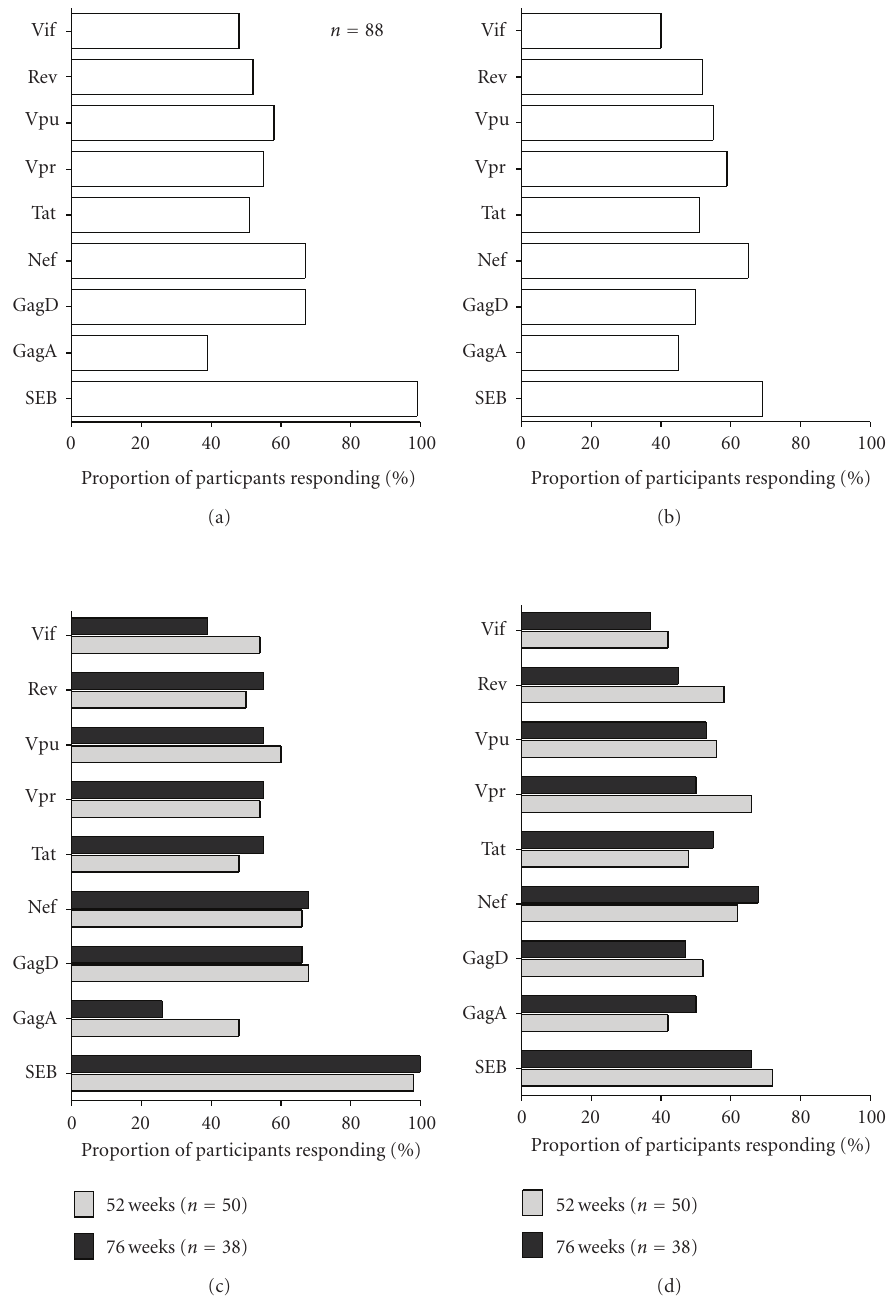
Figure 1: HIV-specific CD8 + T-cell responses at STI/CT randomization. This figure compares the proportions (%) of participants ( n = 88) inducing (a) HIV-specific IFN- γ or (b) Perforin responses at the time point of STI/CT randomization and proportions of participants inducing (c) HIV-specific IFN- γ or (d) Perforin responses at STI/CT randomization initiated 52 or 76 weeks after ART.